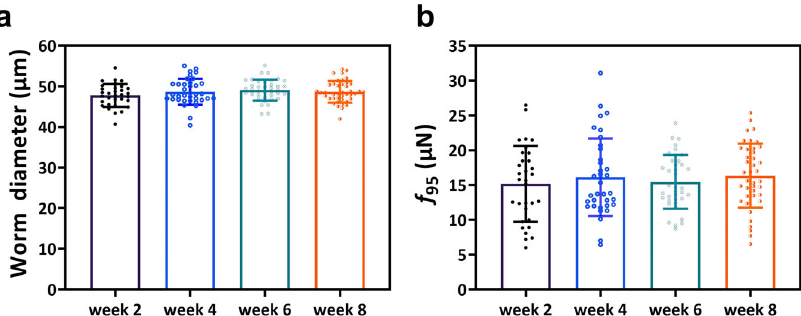
Fig. 7 Measurement of muscle strength for wild-type C. elegans during multigenerational experiment. a Worm diameter over multiple generations. b Muscle strength over multiple generations. n = 32 for week 2, n = 36 for week 4, n = 38 for week 6, and n = 41 for week 8 (Supplementary Table 5). Error bars represent standard deviation. All the data pass the normality test. There is no signi fi cant difference between force values using one-way ANOVA with P =